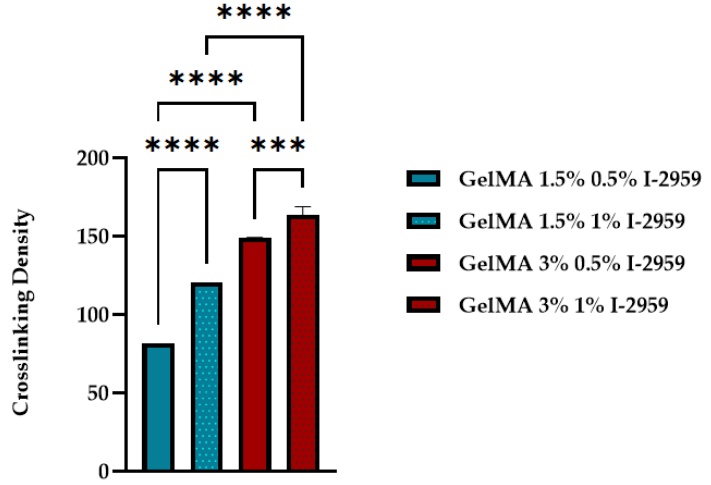
Figure 12. Crosslinking density of GelMA with different degrees of methacrylation and different concentrations of photoinitiator. Statistical significance: *** p < 0.0005; **** p < 0.0001.